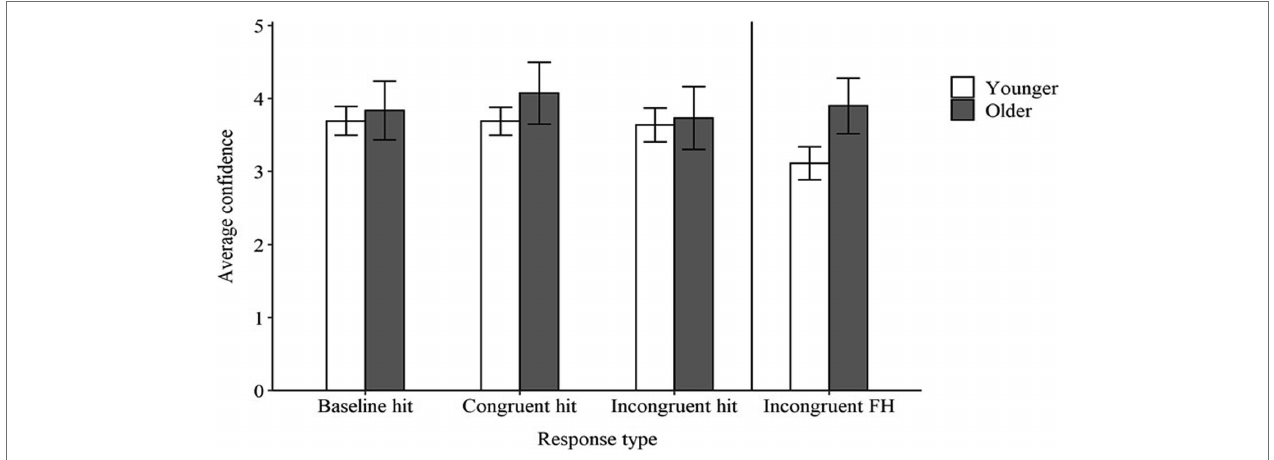
FIGURE 3 | Average confidence in hits in the baseline, congruent, and incongruent conditions, and in cases of false hearing (FH) in the incongruent conditions for younger and older adults. Error bars represent 95% confidence